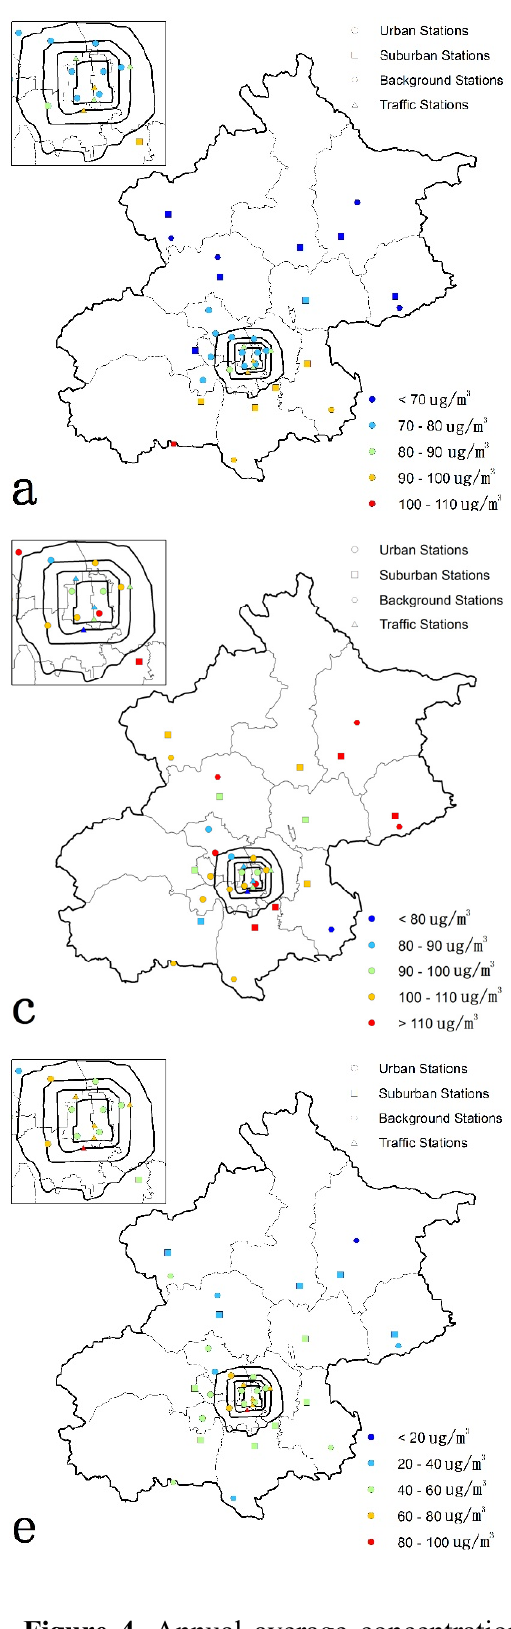
Figure 4. Annual average concentrations of six pollutants (( a ) PM 2.5 ; ( b ) PM 10 ; ( c ) O 3 ; ( d ) SO 2 ; ( e ) NO 2 ; ( f ) CO) of the 35 monitoring